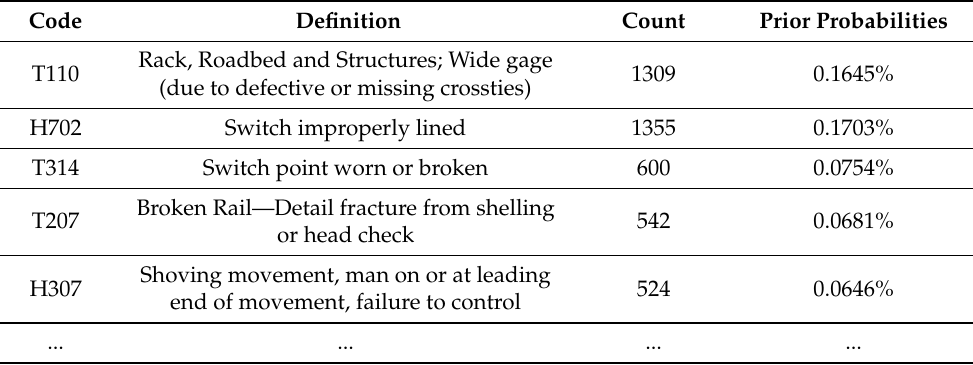
Table 4. Prior probabilities of the basic events.